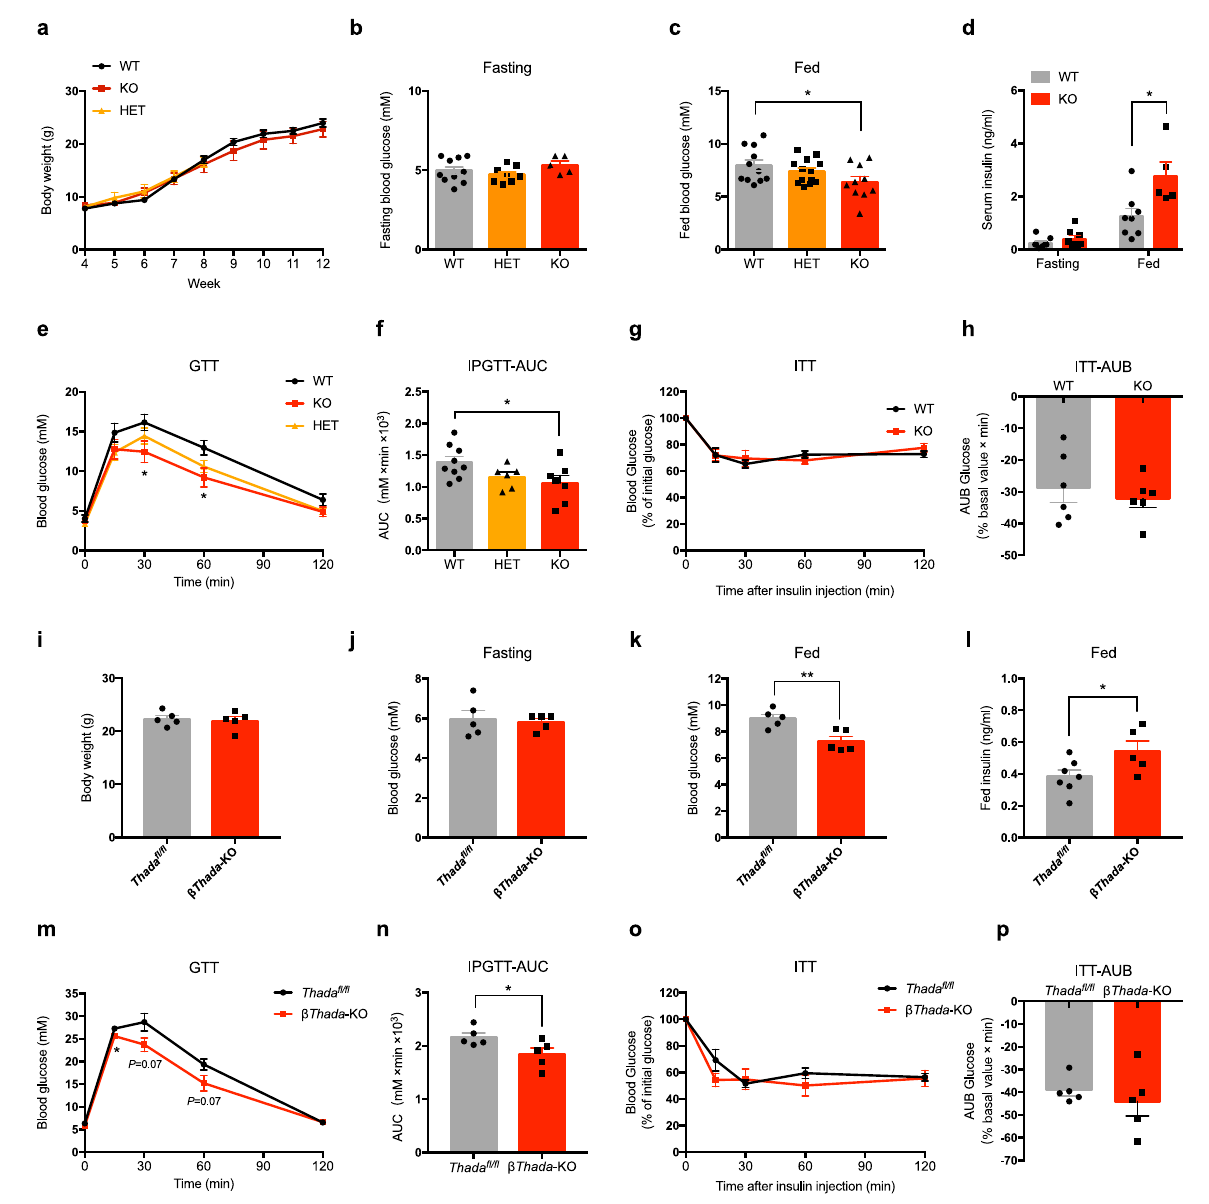
Fig. 2 | Thada knockout improves glucose homeostasis without affecting insulinsensitivityinmice.a Bodyweightsofwild-type(WT, n =13),heterozygous (HET, n =13), and Thada -knockout (KO, n =11) mice at the indicated weeks of age. b FastingbloodglucoselevelsofWT( n =10),HET( n =8)and Thada -KOmice( n =5) that were fasted overnight. c Random-fed blood glucose levels of WT ( n =11), HET ( n =13),and Thada -KOmice( n =10). d Fasting( n =8)andfed( n =8forWTand n =5 for KO) serum insulin levels of WT and Thada -KO mice. e , f IPGTT and the related area under the curve (AUC) of WT ( n =9), HET ( n =6) and Thada -KO mice ( n =7). g , h ITT and the related area under baseline (AUB) of WT and Thada -KO mice